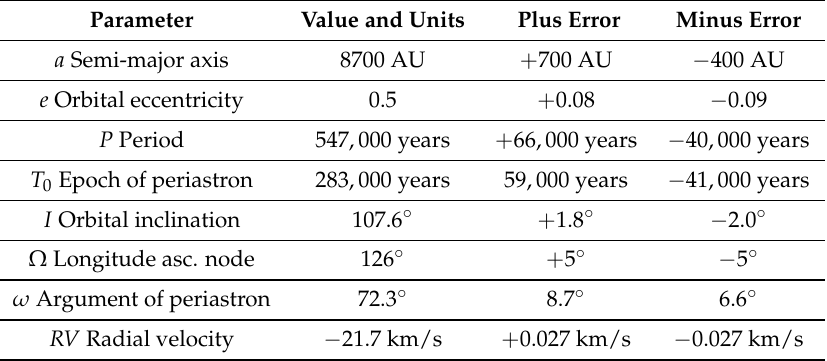
Table 1. Orbital parameters for the osculating keplerian orbit of Proxima Centauri at present as given by Kervella et al. [88]. The angles are written in sexagesimal degrees. Parameter Value and Units Plus Error Minus Error a Semi-major axis 8700 AU + 700 AU − 400 AU e Orbital eccentricity 0.5 + 0.08 − 0.09 P Period 547,000 years + 66,000 years − 40,000 years T 0 Epoch of periastron 283,000 years 59,000 years − 41,000 years I Orbital inclination 107.6 ◦ + 1.8 ◦ − 2.0 ◦ Ω Longitude asc. node 126 ◦ + 5 ◦ − 5 ◦ ω Argument of periastron 72.3 ◦ 8.7 ◦ 6.6 ◦ RV Radial velocity − 21.7 km/s + 0.027 km/s − 0.027